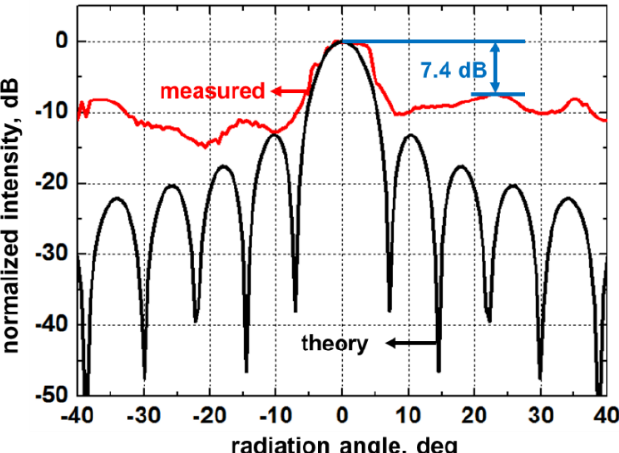
Figure 6. Distribution of normalized intensity measured from the far-field when the beam was formed at the centre.